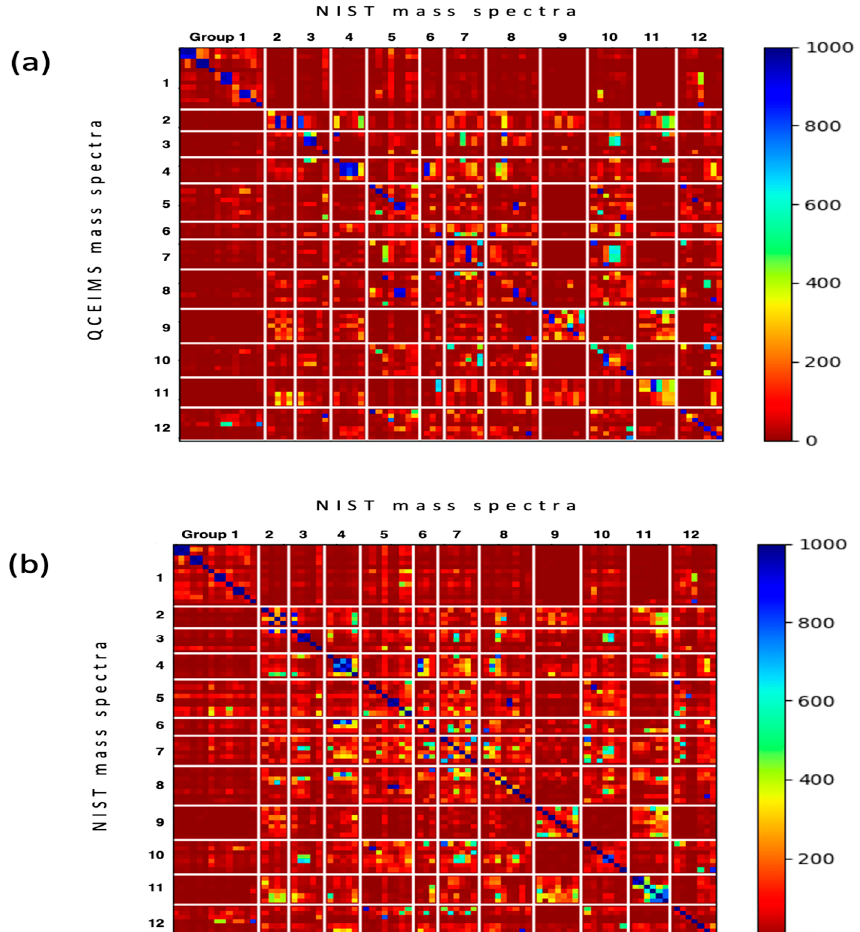
Figure 4. Heatmaps of weighted dot product similarity scored mass spectra sorted by the 12 sub- classes of purines and pyrimidines. ( a ) Matching the 80 QCEIMS predicted versus all experimental mass spectra in the NIST 17 library. ( b ) Matching the target 80 experimental NIST 17 spectra of purines and pyrimidines versus all experimental mass spectra in the NIST 17 library.